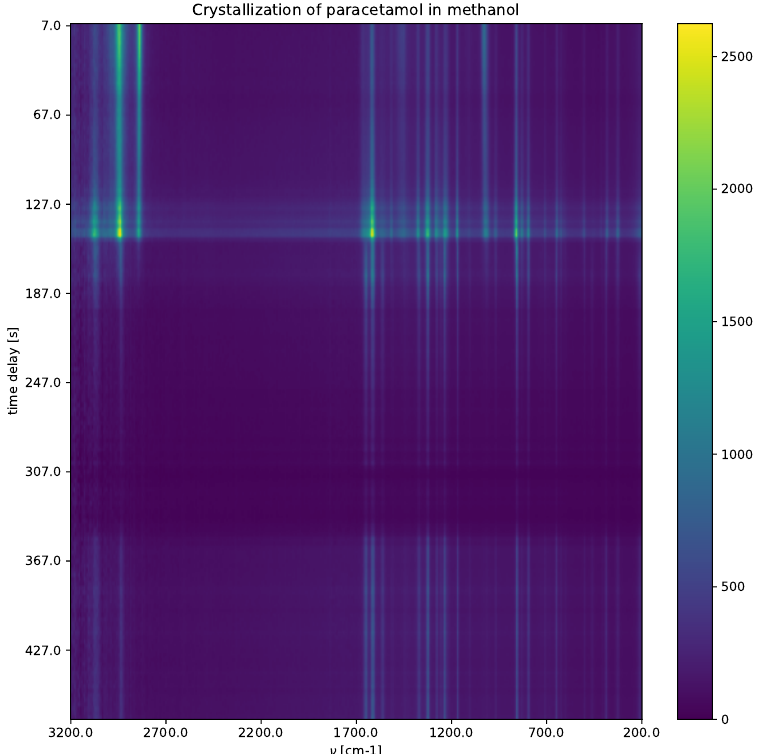
Figure 7. Raman spectrum of the crystallization of paracetamol in methanol. The intensities of the Raman shifts are presented as function of delay time t and Raman shift ν (cm − 1 )